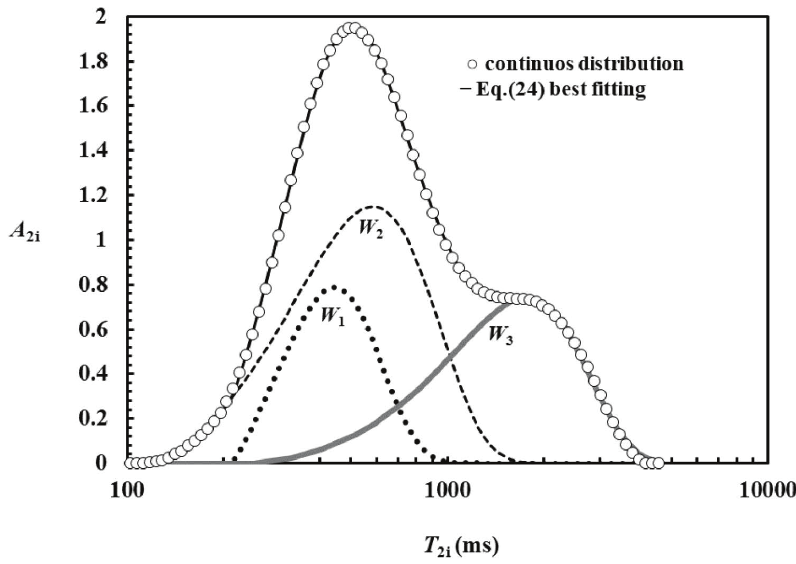
Fig. 5 – Continuous relaxation distribution (A 1 of Tables 1 and 2. The solid black line indicates Eq.(24) best fitting, sum of the three Weibull equations W